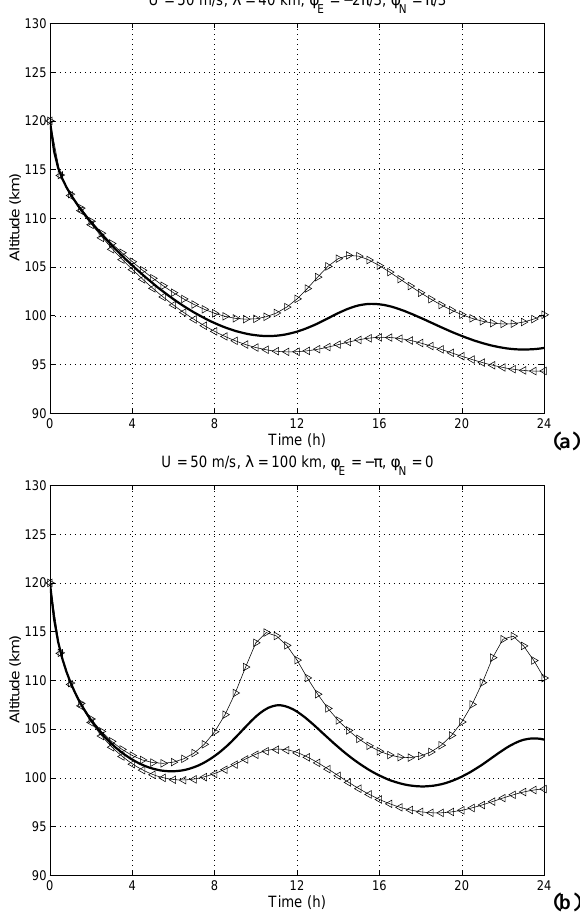
Fig. 2. Ionization trajectories under the action of the tide (thick line), tide + eastward component of the PW (right triangles), tide + westward component (left triangles) for U = 50m/s and W = 15m/s. (a) Wavelength ( λ ) of 40km; (b) wavelength ( λ ) of